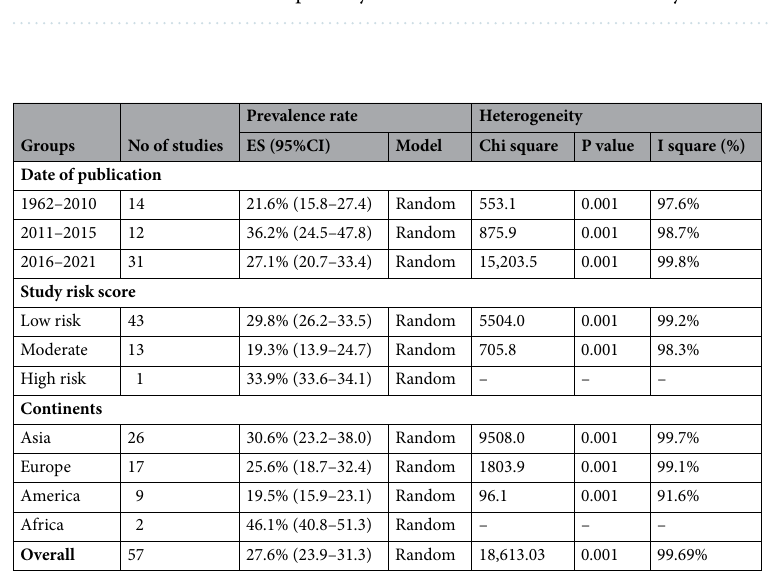
Table 1. Characteristics of the primary studies included in the meta-analysis.